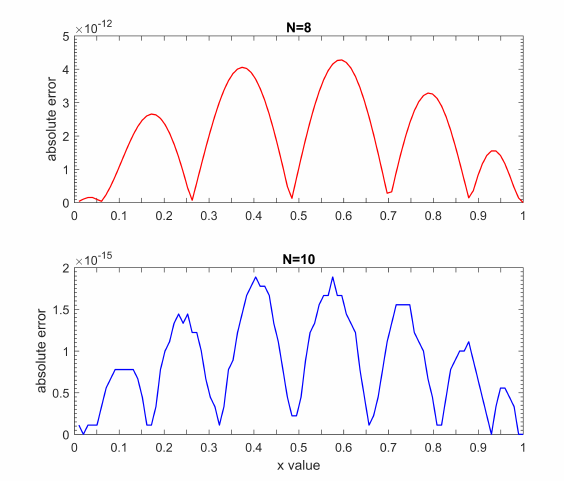
Fig. 2: Absolute errors at N = 8 and N = 10 for example 2.